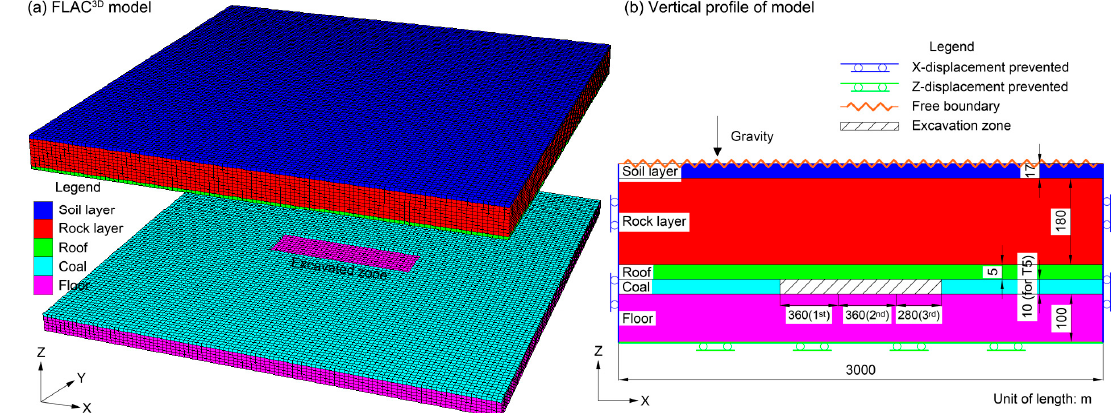
Figure 2. Model of Test 5 after excavation: ( a ) FLAC 3D simulation model (overlying layers are elevated for illustration); ( b ) vertical profile of model with dimensioning and boundary conditions.